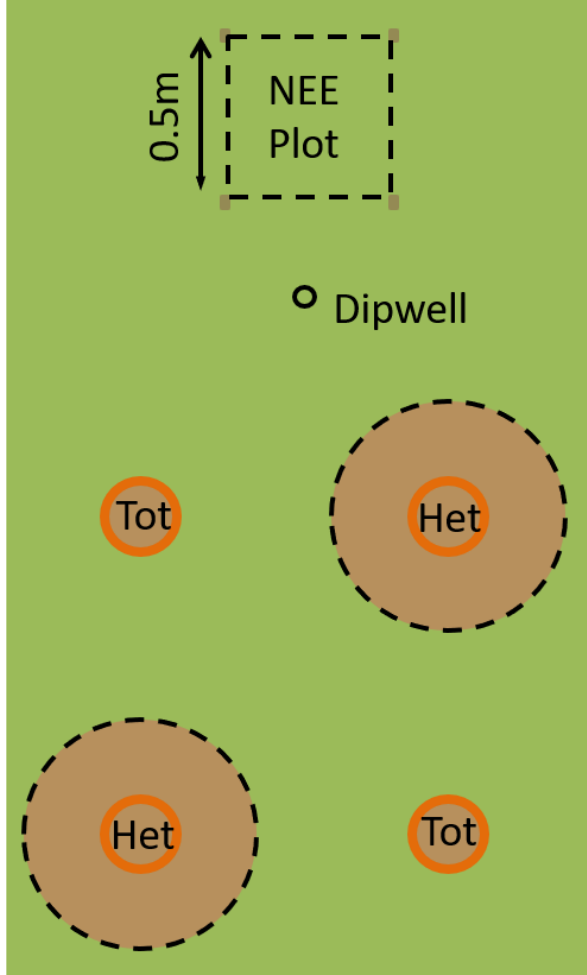
Figure 2. Schematic diagram of the equipment installed at each location showing the net ecosystem exchange plot and the pairs of plots to measure total (clipped) and heterotrophic (trenched and clipped) below-ground